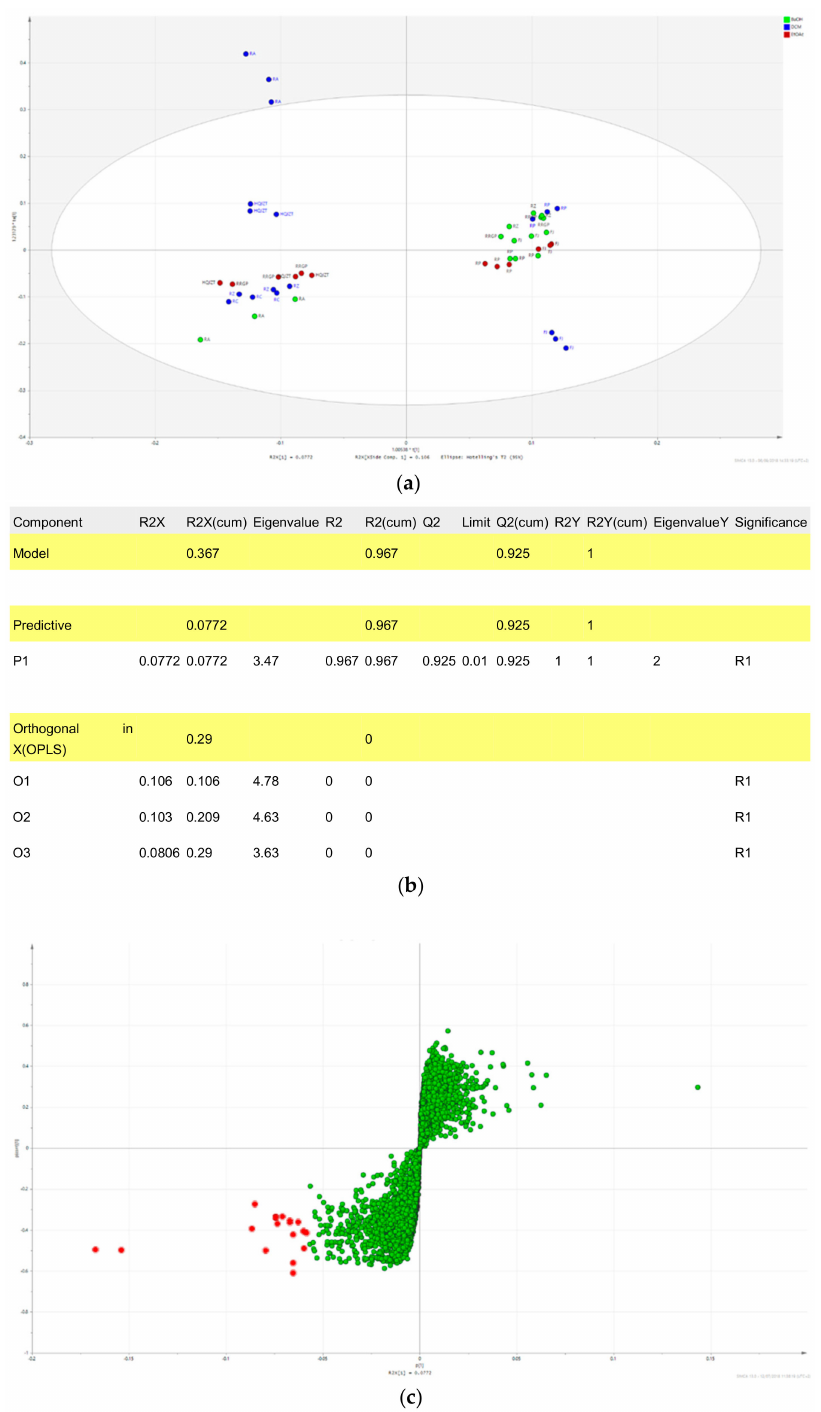
Figure A3. OPLS-DA model using the data from the UPLC-QTOF-MS and pharmacological analysis on inhibition of IL-1 β production (active vs. inactive extracts). ( a ) t[1] / t0[1] Score scatter plot; ( b ) model window; ( c ) S-plot; Hit compounds are marked in